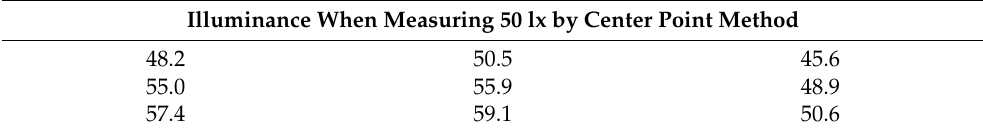
Table 4. Illuminance at 50 lx measured using the center point